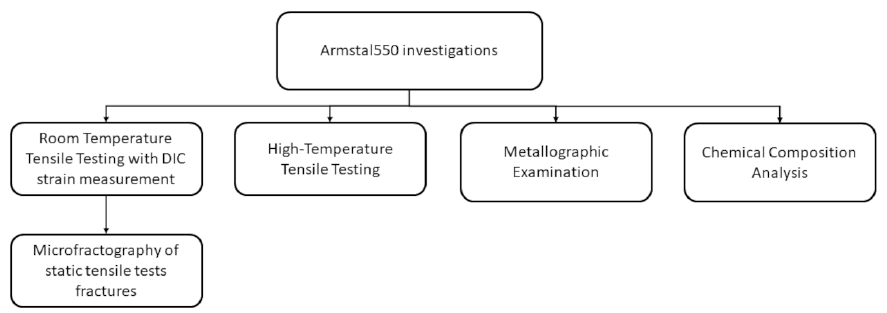
Figure 1. A schematic diagram presenting the scope of the research.